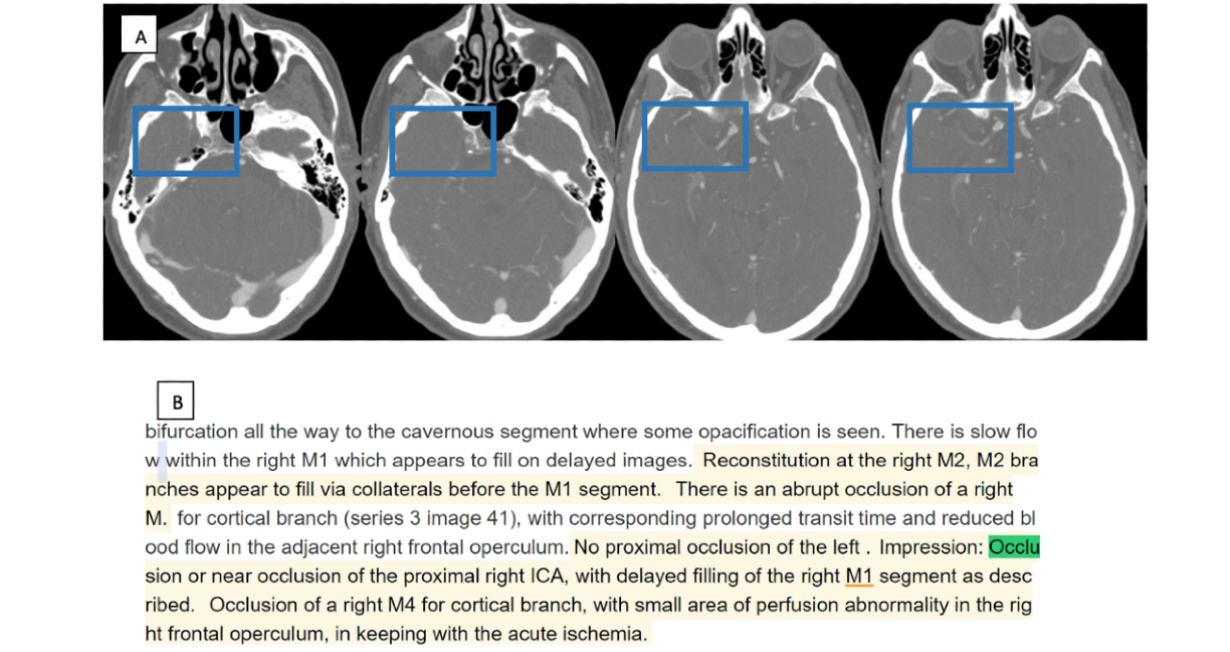
Figure 2. Example 2 of a discrepancy between the chart abstractor and CHARTextract tool output. (A) Computed tomography angiography scan showing near-occlusion of the cavernous internal carotid artery with reconstitution of the middle cerebral artery. (B) CHARTextract output: the abstractor labeled that large vessel occlusion was absent, but the CHARTextract tool determined this attribute to be present because the words “occlusion” and “M1 segment” were detected in the same sentence.